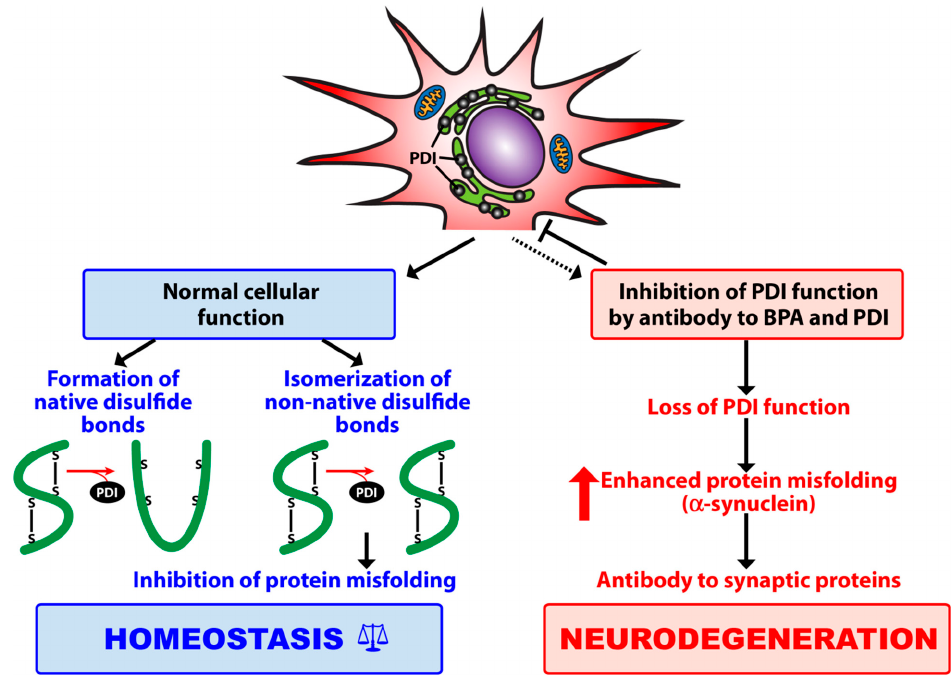
Figure 1. Contribution of protein disulfide isomerase (PDI) to protein folding, inhibition of protein misfolding, and maintenance of cellular homeostasis. The binding of bisphenol A (BPA) to its target enzyme (PDI) plus antibody to BPA and PDI results in loss of PDI functionality, which may contribute first, to alpha-synuclein aggregation and the misfolding of other synaptic proteins, and then to antibody production and